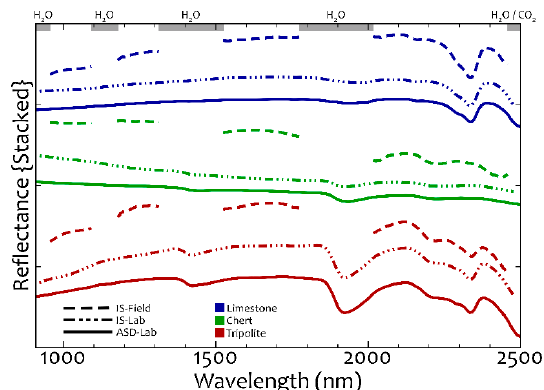
Figure 11. Comparison of mean chert, limestone, and tripolite spectra obtained from laboratory reflectance spectroscopy ( ASD-Lab spectra), extracted from laboratory-based hyperspectral images ( IS-Lab spectra), and extracted from ground-based hyperspectral images ( IS-Field spectra). Wavelengths affected from the atmospheric absorption, indicated as gray blocks, are masked in the IS-Field spectra. The spectra are stacked by 0.1 offset for clarity.